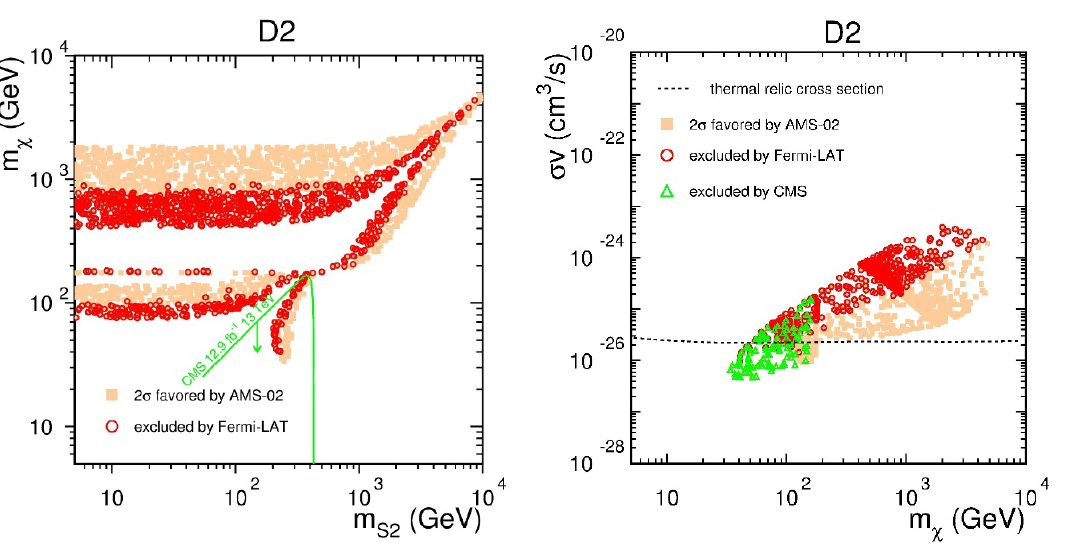
Figure 5 . Left: the AMS-02 favored region of masses ( m (cid:31) vs. m S model D 2 we consider. The solid squares estimate 2 (cid:27) con(cid:12)dence region. The green curve is the LHC exclusion limit [58]. Right: the AMS-02 favored region of cross sections ( (cid:27)v vs. m (cid:31) ). The green points are excluded by LHC search. The red circles are excluded by Fermi-LAT dSphs. The black dashed curve corresponds to the thermal cross section [59].